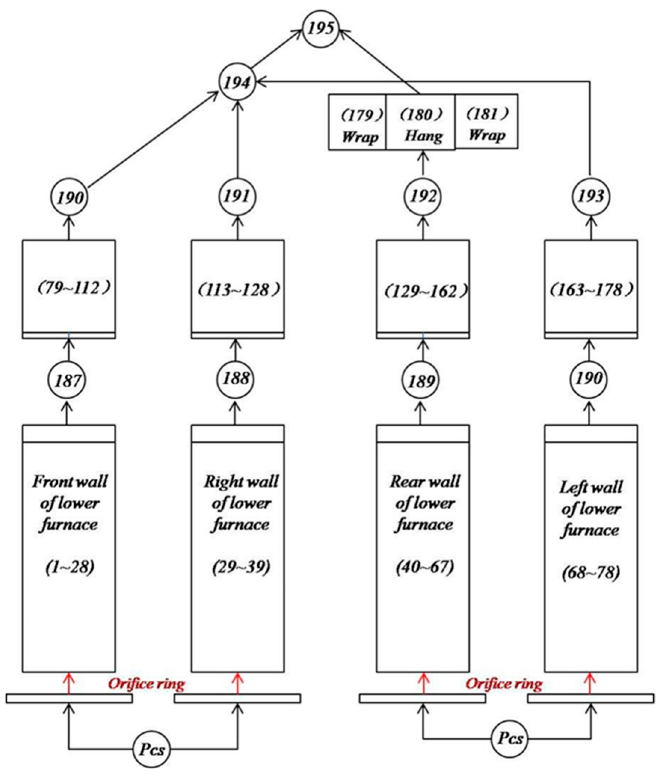
Figure 6. Schematic of Water-Cooled Wall Flow